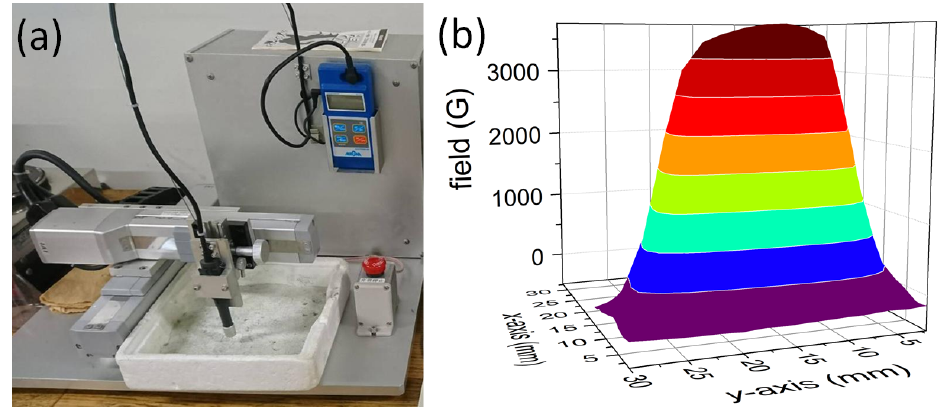
Figure 2. ( a ) Image of the home-built TF measurement setup; ( b ) Field distribution above the square-shaped permanent magnet (30 × 30 × 25 mm 3 ) applied to magnetize the foam